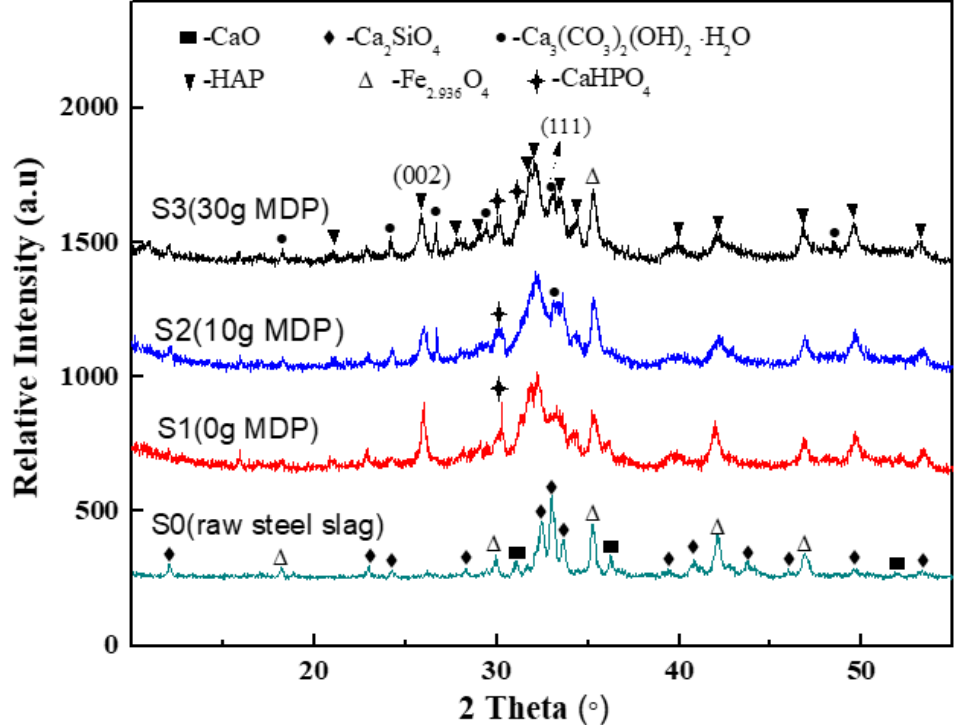
Figure 1. The XRD patterns of raw steel slag and the nanocomposite samples prepared with different additions of MDP.